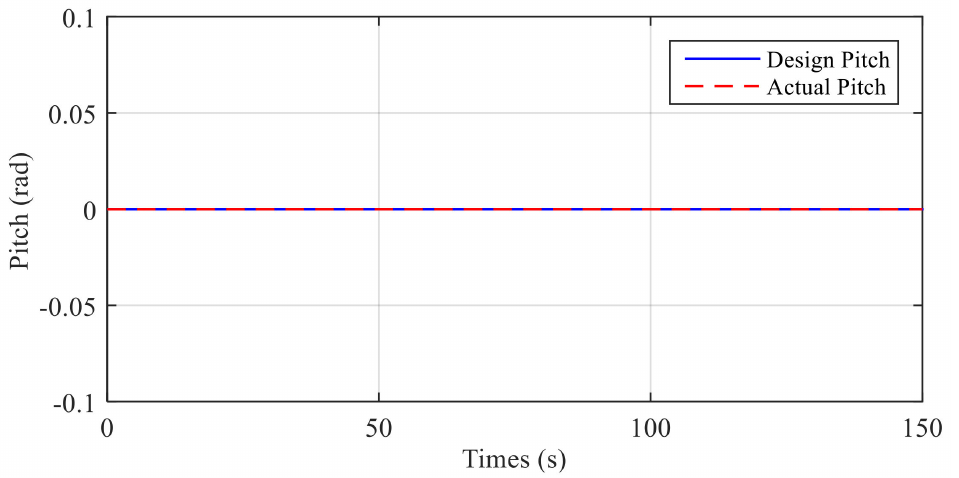
Figure 8. The pitching attitude of the